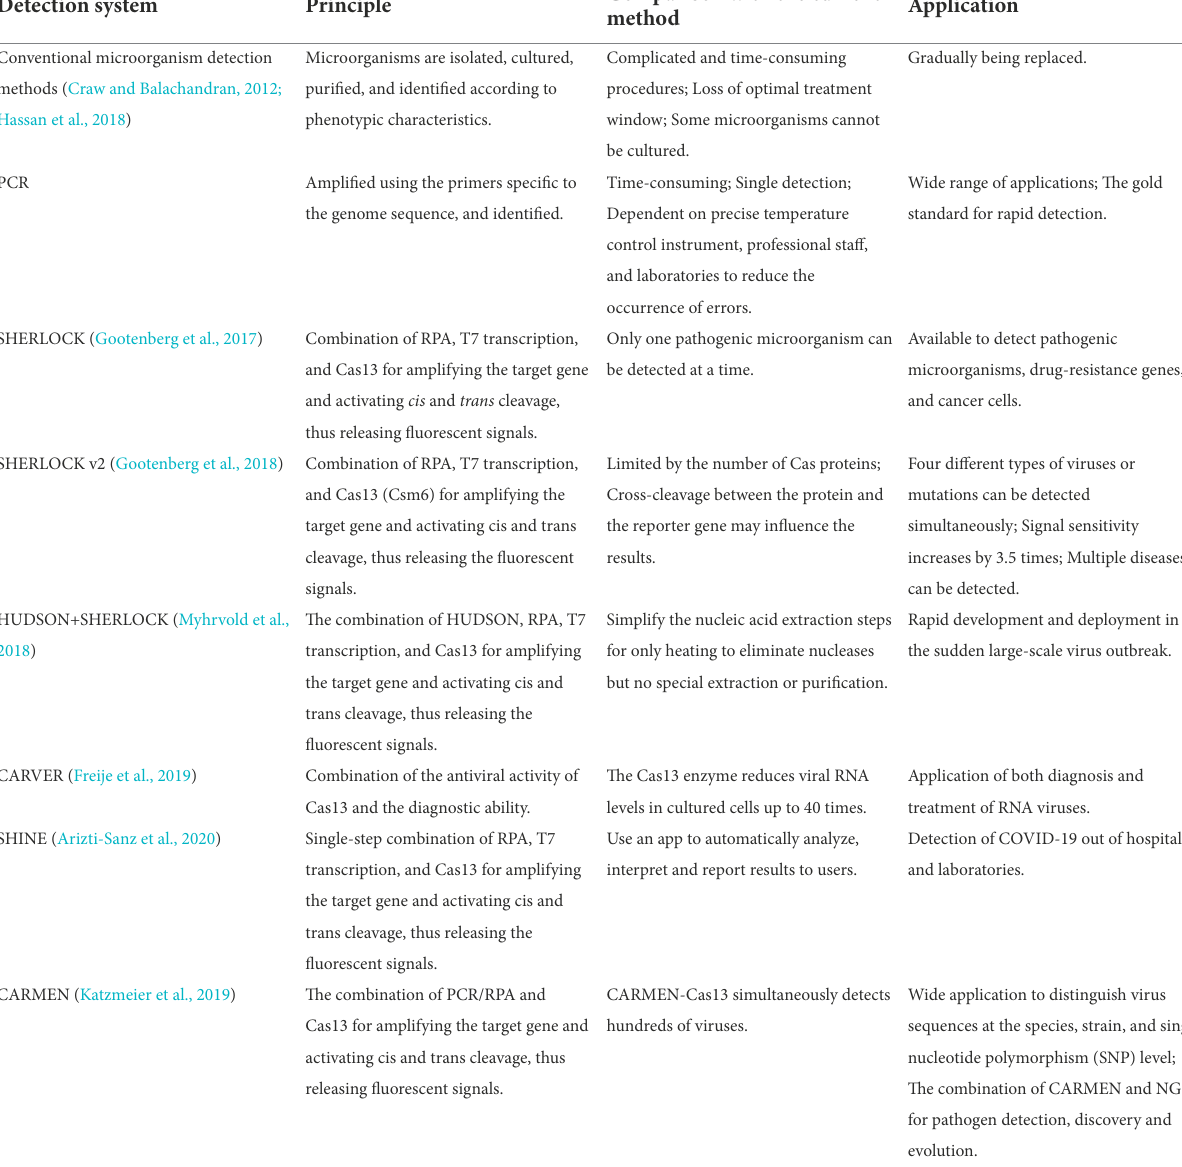
TABLE 3 Comparison of the pathogenic microorganism detection